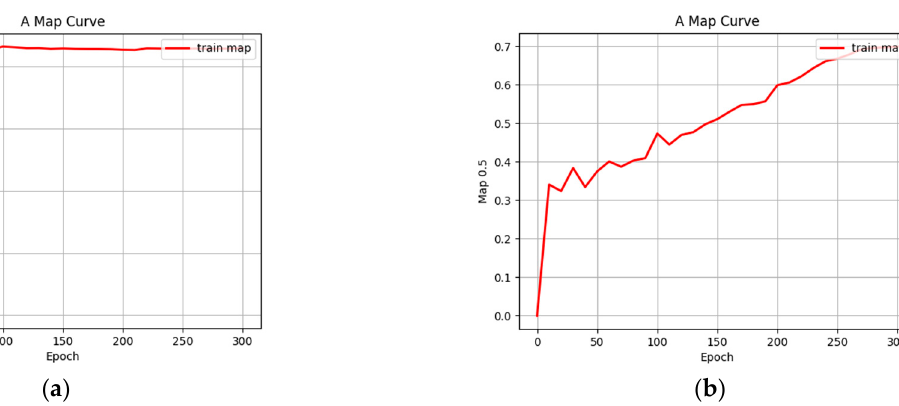
Figure 12. Comparison of mAP between ST-YOLOv5 and YOLOv5. ( a ) ST-YOLOv5 model mAP curve. ( b ) YOLOv5 model mAP curve.